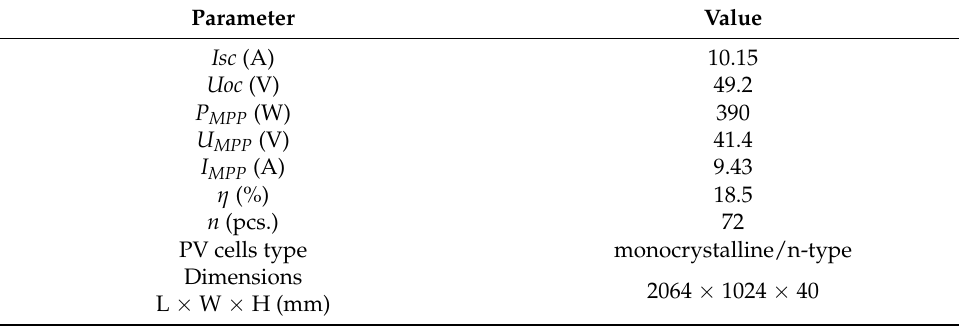
Table 1. The bifacial module parameters—LG 390-N2T-A5 in STC [36].